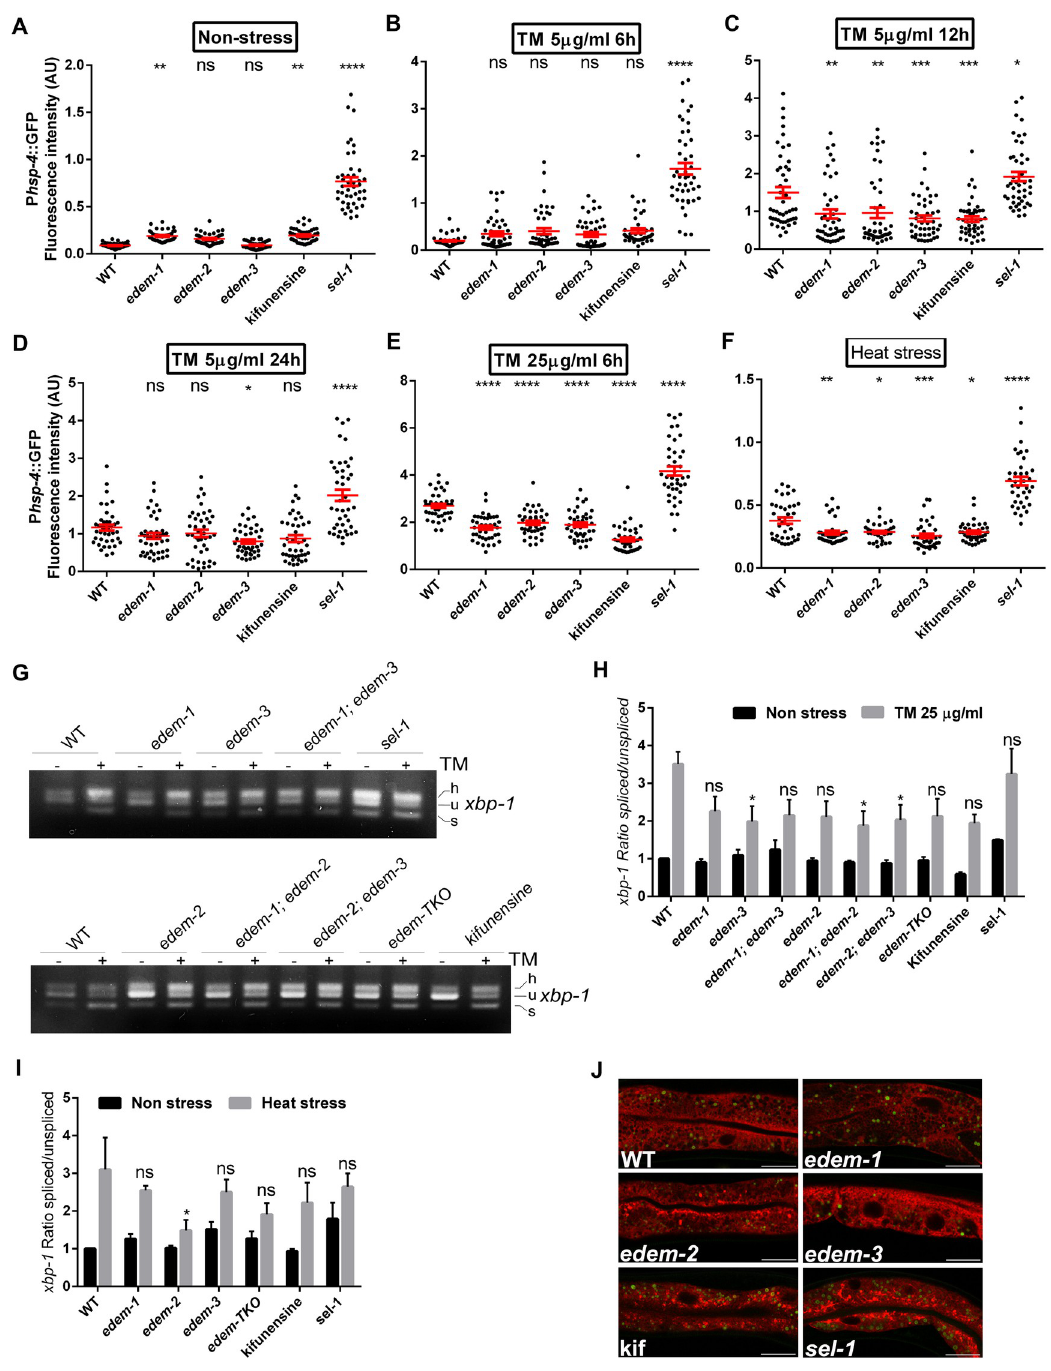
Fig 7. EDEM depletion mitigates the ER stress without activation of IRE-1/XBP-1 pathway. (A-F) Quantification of WT (EV) or RNAi-treated day one adults carrying P hsp-4 ::GFP transgene, subjected or not to the indicated tunicamycin and heat shock treatment. The worms were kept on RNAi plates for one generation before exposure to ER stress treatments. Values represent mean fluorescence/ μ m 2 x 1000. The red bars indicate the average ± SEM (G-H) Young adults were non-treated (NS) or treated with tunicamycin (25 μ g/ml, 6h) for xbp-1 splicing from indicated strains. Total RNA was isolated, reverse transcribed and used for PCR analysis of xbp-1 splicing forms. In (G) h-hybrid, u-unspliced and s-spliced denote the forms of xbp-1 mRNA detected in the agarose gel. (H) Band intensity of samples was quantified and the ratios of spliced/unspliced xbp-1 normalized to WT untreated samples were plotted in the graph. Values in the graph represent the mean of 4 independent experiments ± SEM (Two way ANOVA, Dunnett’s multiple comparisons test). (I) Young adults were non-treated (NS) or heat shocked (4h at 35˚C) for